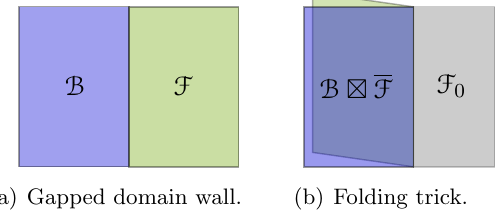
Figure 3 . (a) A bTO B and an fTO F connected by a GDW via condensing some fermions in B . Via the folding trick along the GDW, (a) is equivalent to (b) A topological order B ⊠ F sharing a gapped boundary with F 0 , a fermionic